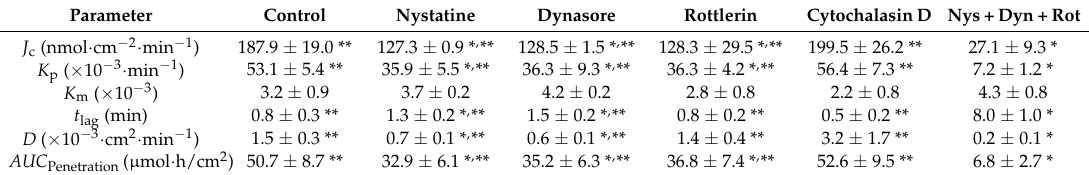
The skin samples were co-treated with KET-NPs formulation and inhibitors [0.5% DMSO (control), 54 µ M nystatin, 40 µ M dynasore, 2 µ M rottlerin or 10 µ M cytochalasin D]. Nys + Dyn + Rot was showed the multi-treated